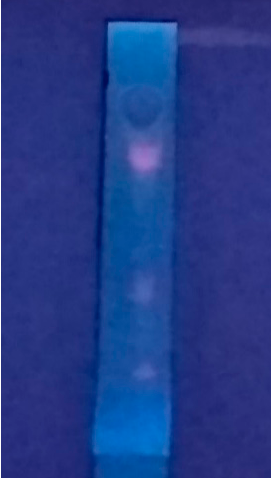
Figure 6. TLC plate observed in UV chamber.